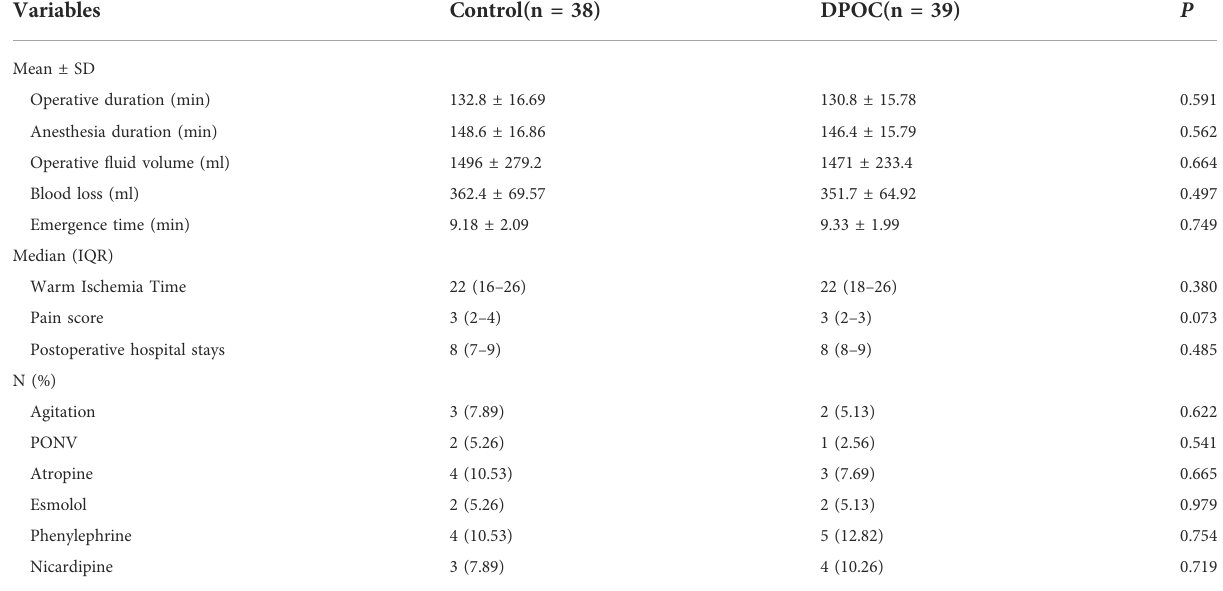
TABLE 2 Operative and postoperative